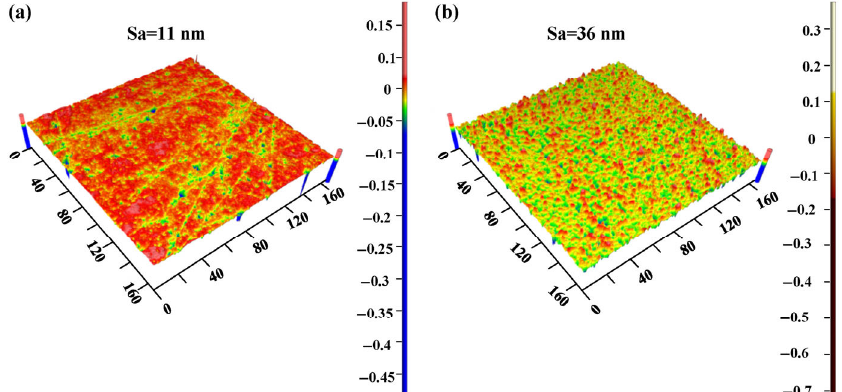
Fig. 3 Surface topographies of: (a) non-irradiated YN6; (b) irradiated YN6 (Unit: μ